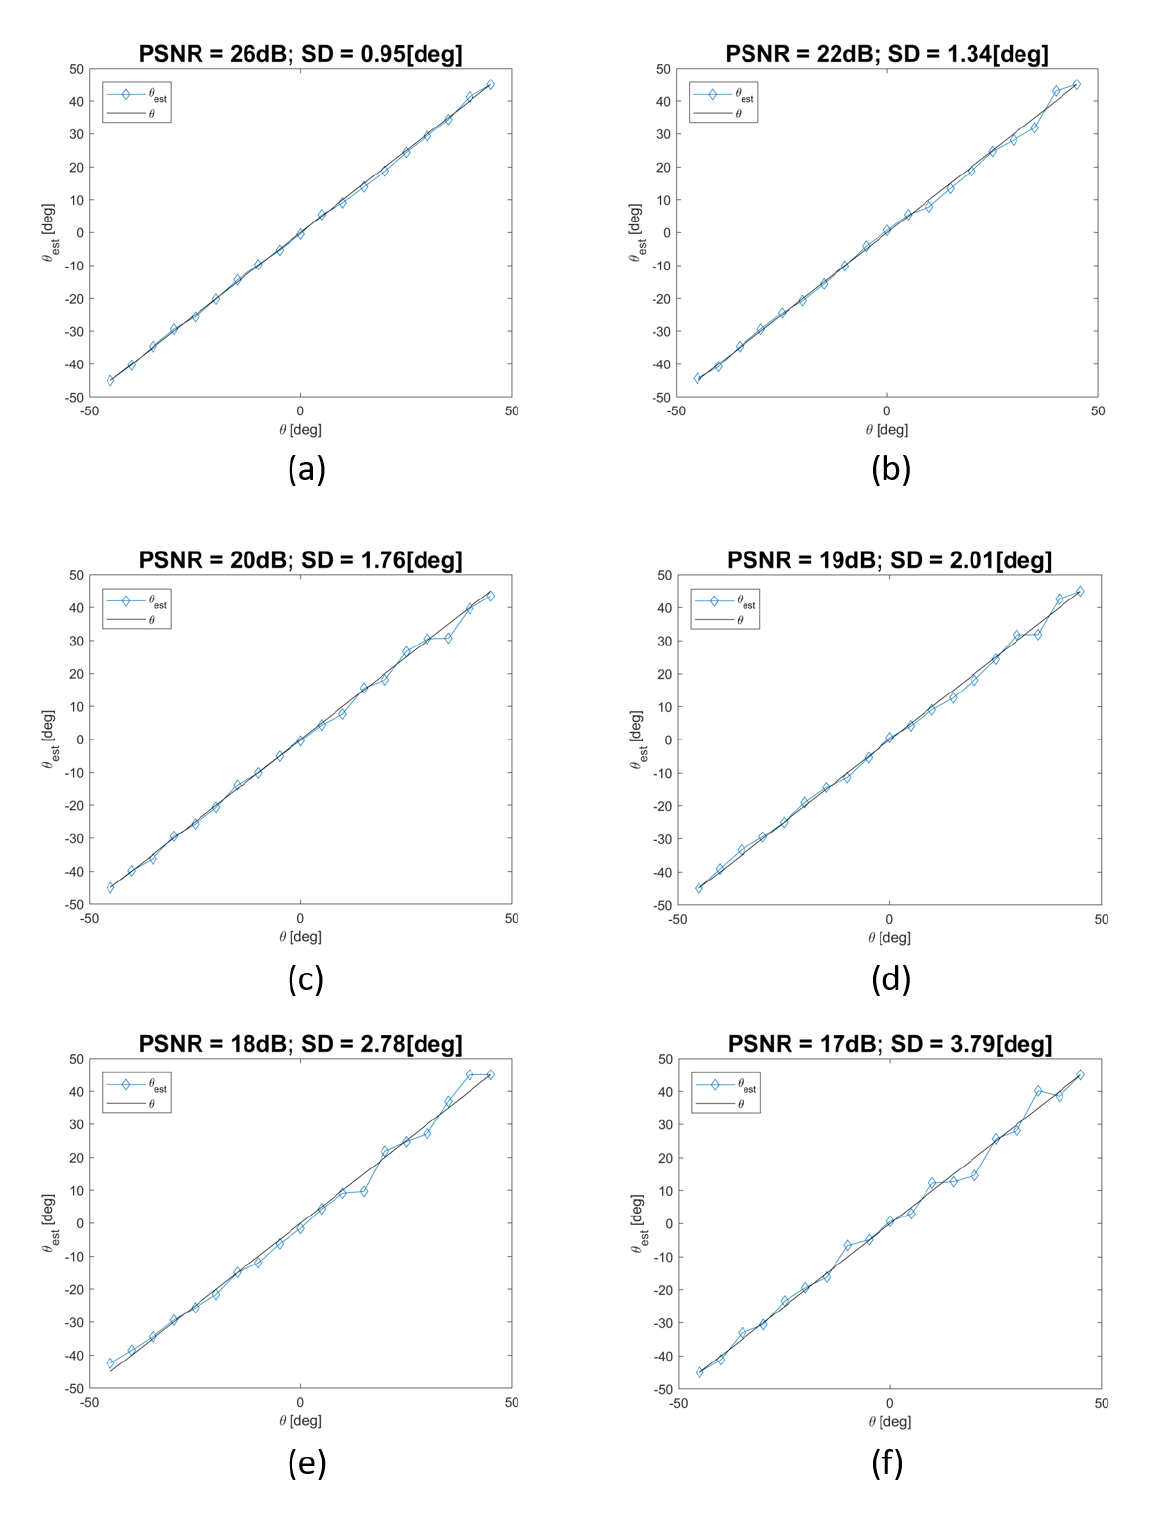
Figure 8. Estimated DoA ( θ est ) with respect to the actual DoA ( θ ) for noise-affected measurements (additive white Gaussian noise) at different PSNR values (indicated in the title of subplots, with the computed value of standard deviation of DoA). The plotted results were computed by simulating the A 0 mode propagation, with Fs = 1